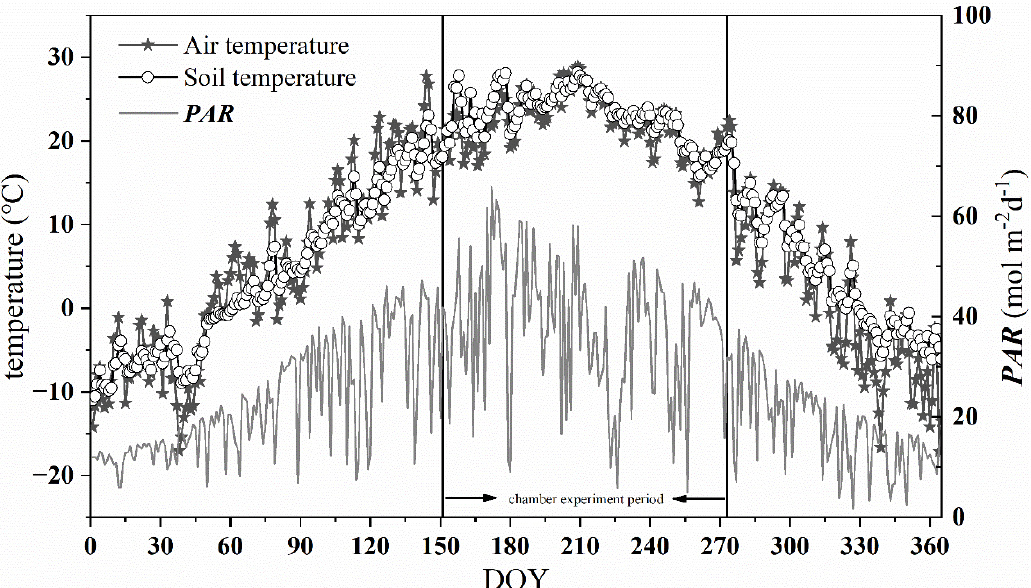
Figure 2. Daily average air temperature ( T air ), soil temperature ( T soil ) at a depth of 10 cm, and daily total photosynthetically active radiation ( PAR ) at the study site. The chamber experiment period (from 1 June to 30 September 2019) was especially marked.